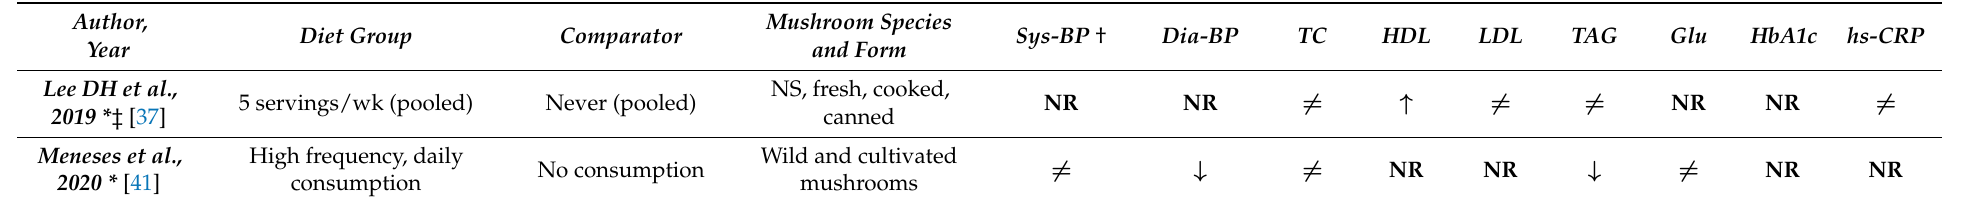
Table 6. Qualitative summary of observational studies evaluating cardiometabolic disease risk factors in adults consuming higher vs. lower amounts of